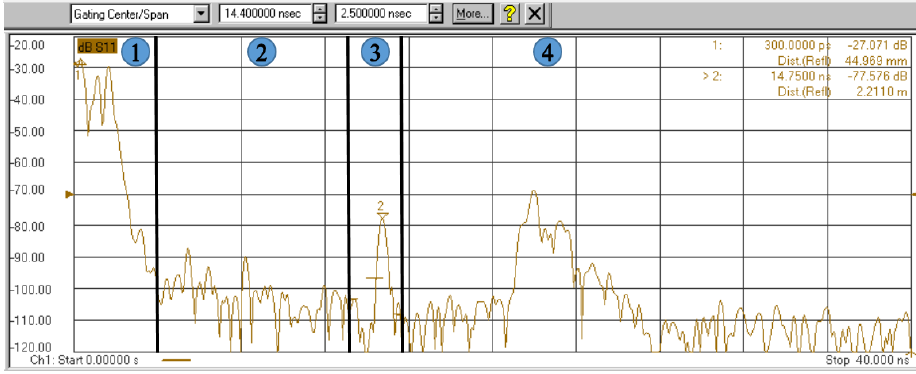
Fig. 5. The time domain plot for the reflection signal in laboratory bench with the quadrocopter Syma X12, horizontal polarization.